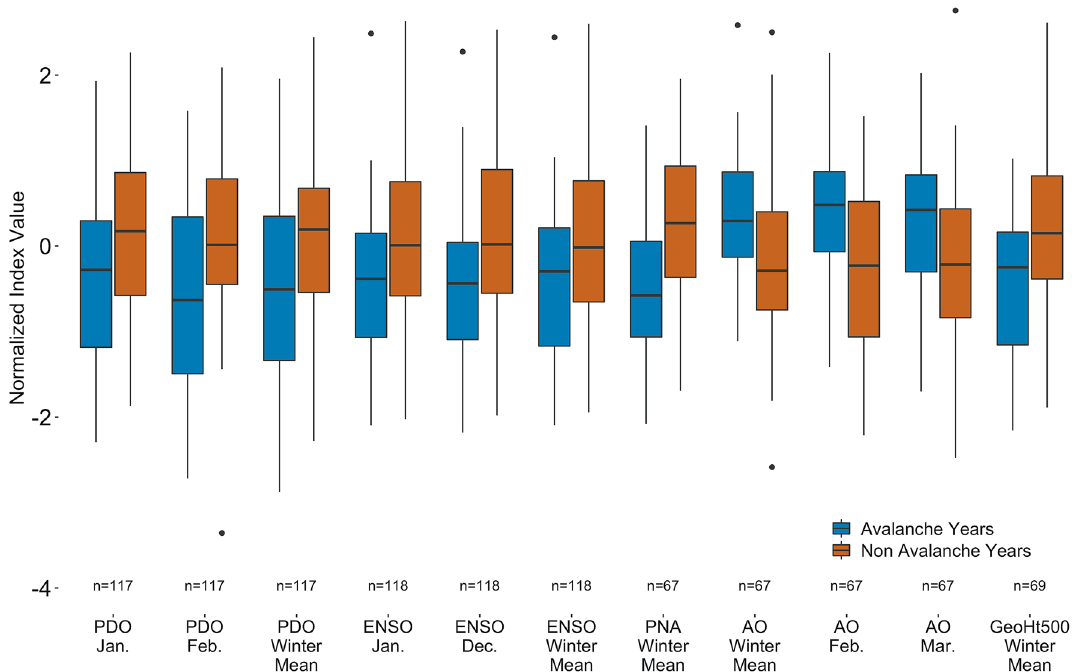
Figure 3. Boxplots of atmospheric variables and indices exhibiting a significant ( p = 0.05) difference between conditions occurring in avalanche (blue) versus non-avalanche (red) years using the Wilcoxon rank-sum test. Sample size varies due to varying periods of record for each variable (Supplementary Table S6). Y-axis is the normalized indices of all variables for direct comparison. Full descriptions of results of each atmospheric variable are shown in Supplementary Table